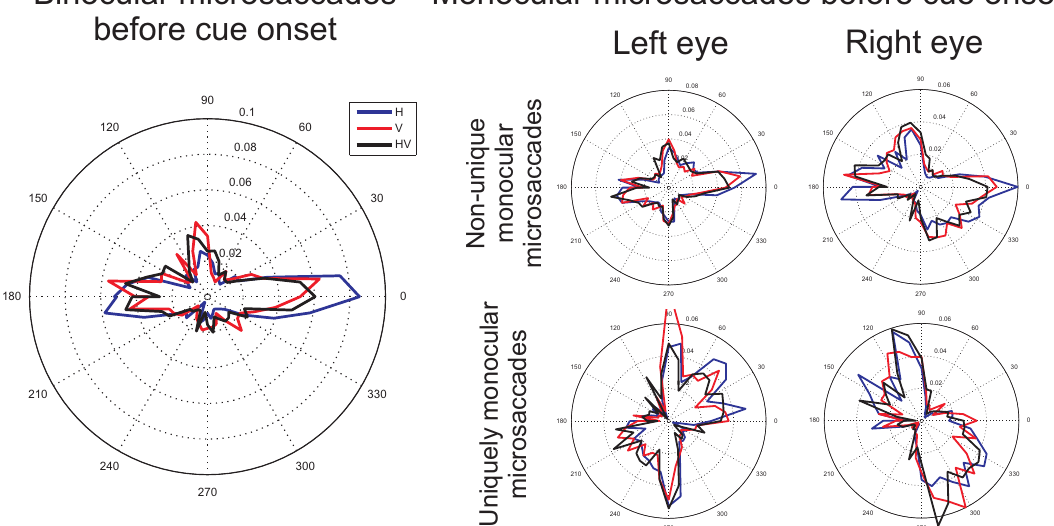
Figure 4 . Average histograms (proportions of microsaccades) across participants of the microsaccade directions before cue onset (from -1000ms to 0ms before cue onset), during which the fixation symbol was shown to the participant. Blue, red, and black lines show the distribution of microsaccade directions for the horizontal, vertical and combined horizontal and vertical conditions respectively. On the left, histograms of microsaccades that occurred simultaneously in both eyes are shown. On the right, microsaccades from data of one eye only are shown, with in the top two plots, all the microsaccades that occurred in the indicated eye, independent of whether a microsaccade also occurred in the other eye and in the bottom two plots (comparable to when only one eye would have been recorded), the microsaccades that occurred uniquely in the indicated eye. crosaccades. Overall, however, no difference in the per- centage of horizontal and vertical microsaccades were found (left eye: F(1,7)=0.88, p=0.38; interaction